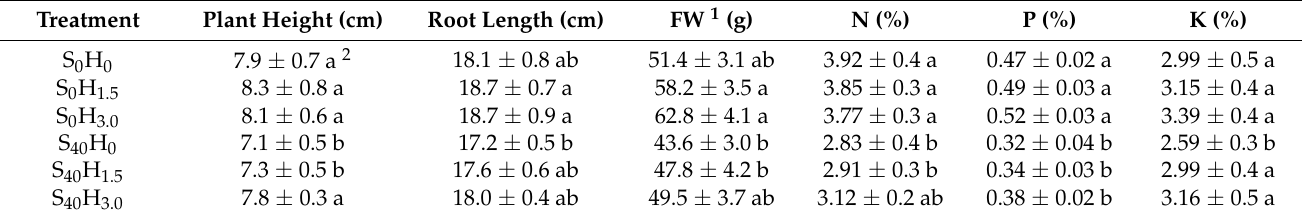
Table 1. Plant height, root length, dry weight, and leaf nutrition data of lettuce treated with two salt concentrations and three sulfur fertilizer